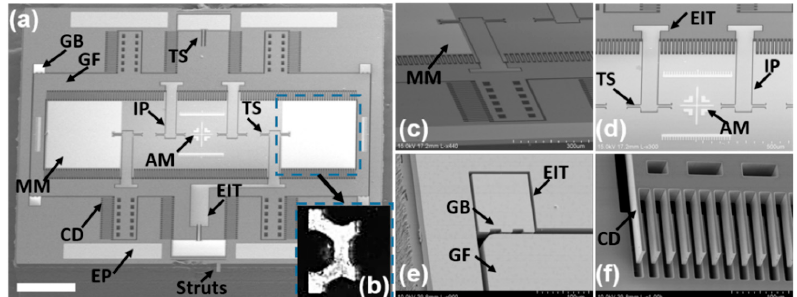
Figure 5. SEM and stereomicroscopic images of the 2D Au-coated resonant MEMS scanner. ( a ) MEMS chip with a 3.2 mm (horizontal) × 2.9 mm (vertical) footprint, scale bar: 500 µm; ( b ) zoom-in view stereomicroscopic image of the backside enhancement structures (50 µm thick) under the Au-coated scanning micro-mirror; the image was taken when the chip was upside down; ( c ) gimbal frame with the inner micro-mirror; ( d ) inner micro-mirror with “cross” shaped alignment marks at the center and two paralleled rulers; ( e ) edge of the gimbal frame with its protection bumper for the sidewall stop to avoid shorting the electricity; ( f ) comb-drive actuator fingers on the outer gimbal frame; notes: the gimbal frame was tilted with pre-loaded torque to expose the sidewall of comb-drive actuator fingers during SEM. Notes: GB, gimbal frame’s bumper; GF, gimbal frame; AM, alignment marks; MM, micro-mirror coated with Au/Ti; TS, torsion spring; IP, inner piers for micro-mirror; EP, electrical pads; CD, comb-drive actuator fingers.